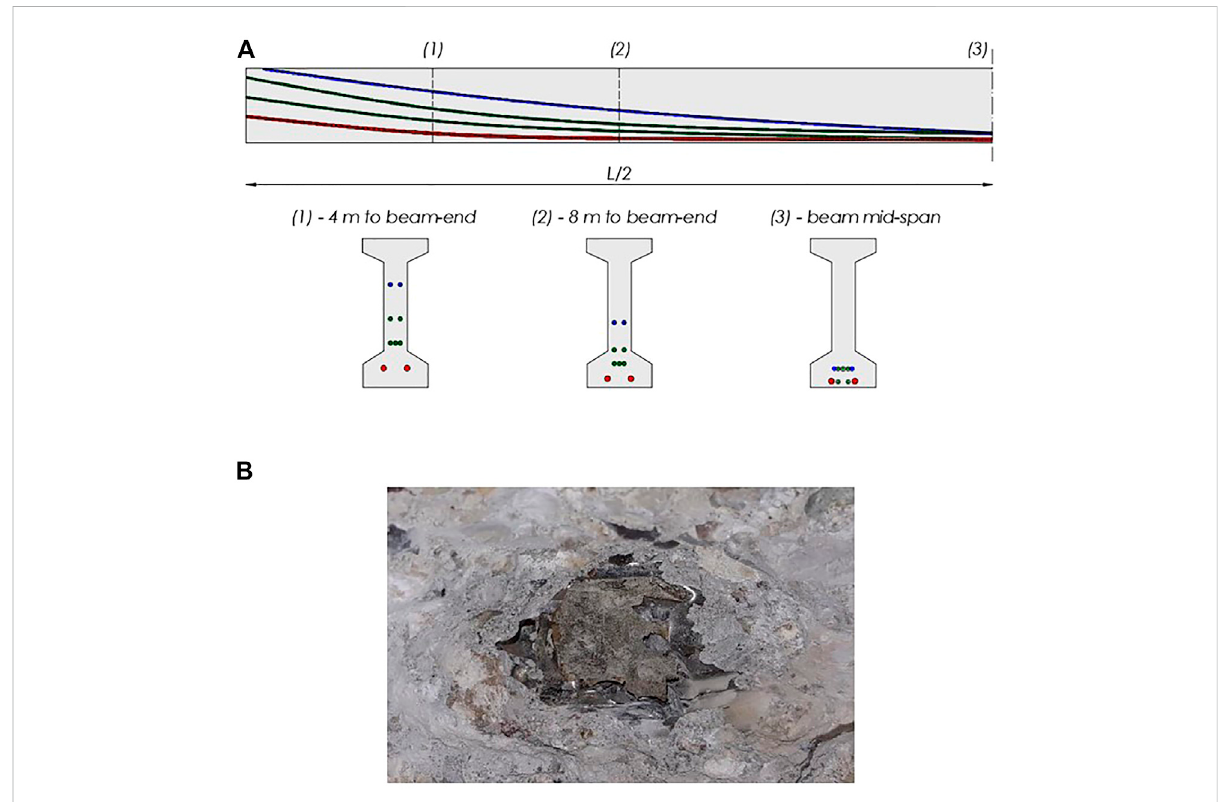
FIGURE 9 (A) Longitudinal pro fi le of prestressing tendons along the beam length (half-span) and cross-section geometry of the double-T beams in three relevant sections and (B) condition state of the metallic duct and internal